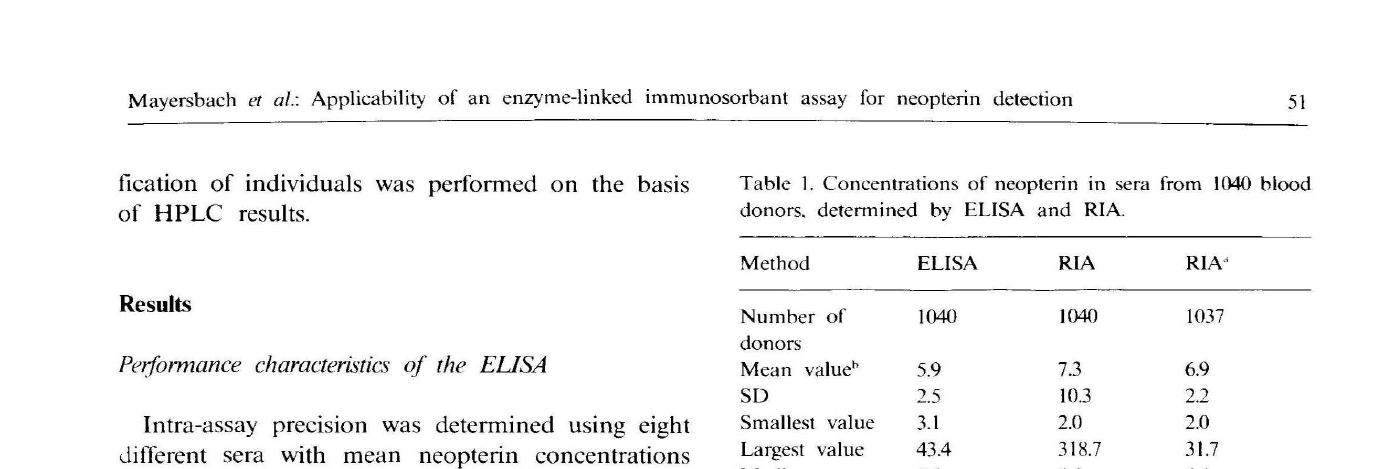
Pteridines / Vol. 5 / No.